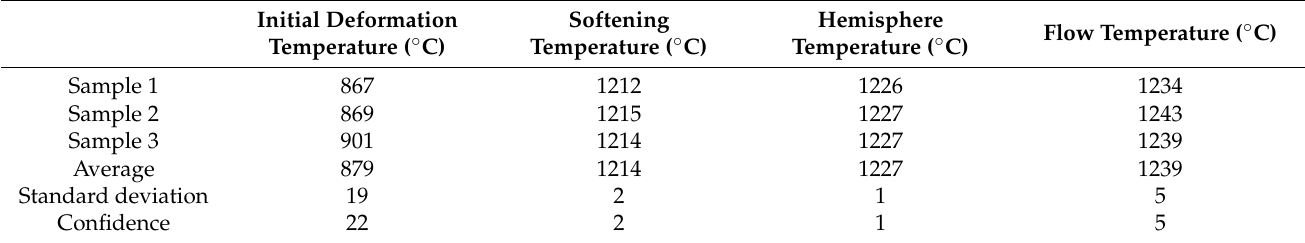
Table 11. Ash fusibility temperature analysis: initial deformation temperature, softening temperature, hemisphere tempera- ture, and flow